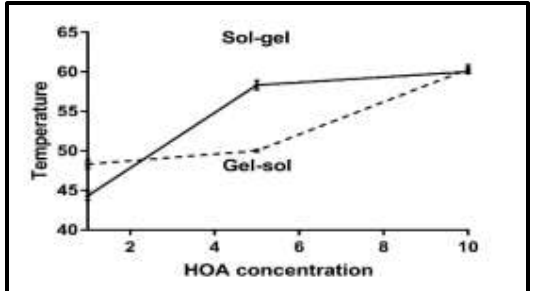
Figure 2. Sol to gel and gel to sol transitions temperatures of selected HOA in SO organogels by vial inversion method.